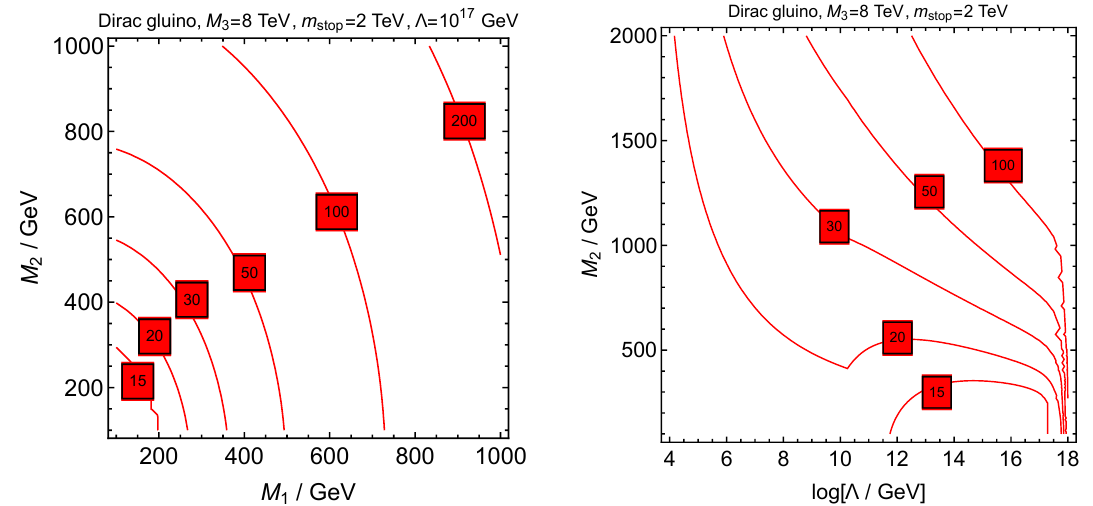
Figure 5 . Fine-tuning in the plane M 1 (cid:0) M 2 with a Dirac gluino for (cid:3) = 10 17 GeV and maximal value of the SU(2) X gauge coupling constant, g max , that do not induce the Landau pole below X the mediation scale (left panel). In the right panel, (cid:12)ne-tuning in the plane (cid:3) (cid:0) M 2 is shown for M 1 = 100 GeV and g X = min(1 : 5 ; g max ). The remaining parameters are the same as in (cid:12)gure X